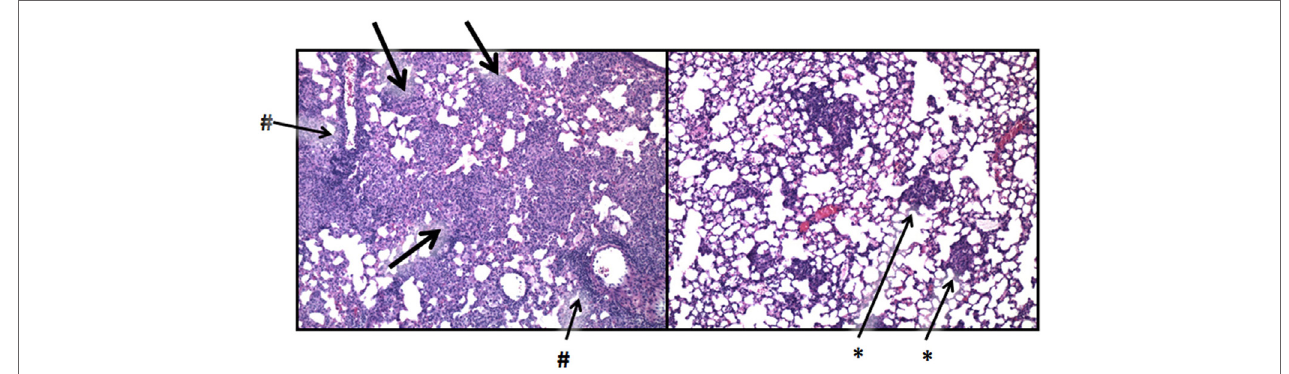
FigURe 7 | Lactoferrin (LTF) modulation of the mycobacterial granulomatous response. C57BL/6 mice were challenged with mycobacterial glycolipid trehalose 6,6 ′ -dimycolate (TDM) prepared as described (42). TDM induces severe granulomatous responses comprised of activated monocyte/macrophages, with peak inflammatory response shown postinjection (left). Aggressive granulomatous response includes large mononuclear cell accumulation (thick arrows) and severe lymphocytic perivascular cuffing (#). Administration of LTF at 1 day postchallenge nearly abolishes the pro-inflammatory response, and restores normal lung architecture (right), with only focal residual monocytic infiltrates remaining (*). Photomicrographs were previously described in detail, and represent studies published in full in Welsh et al. (42). Similar results were described using recombinant human LTF (127). Sections were visualized at 100 × magnification, stained with hematoxylin and